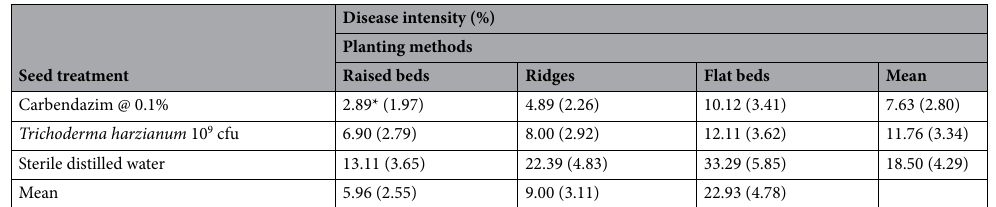
Table 5. Effect of seed treatment and planting methods on disease intensity (%) of root rot of pea under field conditions. *Figures in parenthesis are square transformed values. C.D ( p ≤ 0.05). Planting method (M): 0.184. Seed treatment (S): 0.184. (M × S): 0.319.